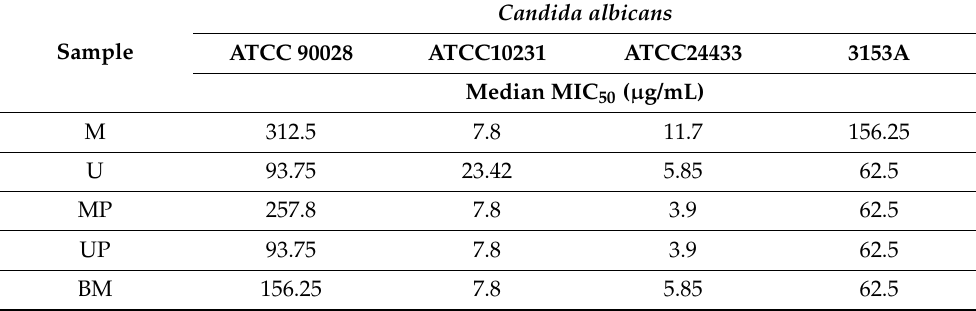
Table 3. Antifungal activity of Clery strawberry samples against four strains of Candida albicans (Antifungal activity was determined according to Clinical and Laboratory Standards Institute guidelines (CLSI docu- ment M38-A2, 2008). Minimal inhibitory concentration (MIC) was determined. MIC 50 and MIC 90 = the lowest drug concentration that prevented 50% and 90% of growth with respect to the untreated control, respectively. The values shown are the median from three independent